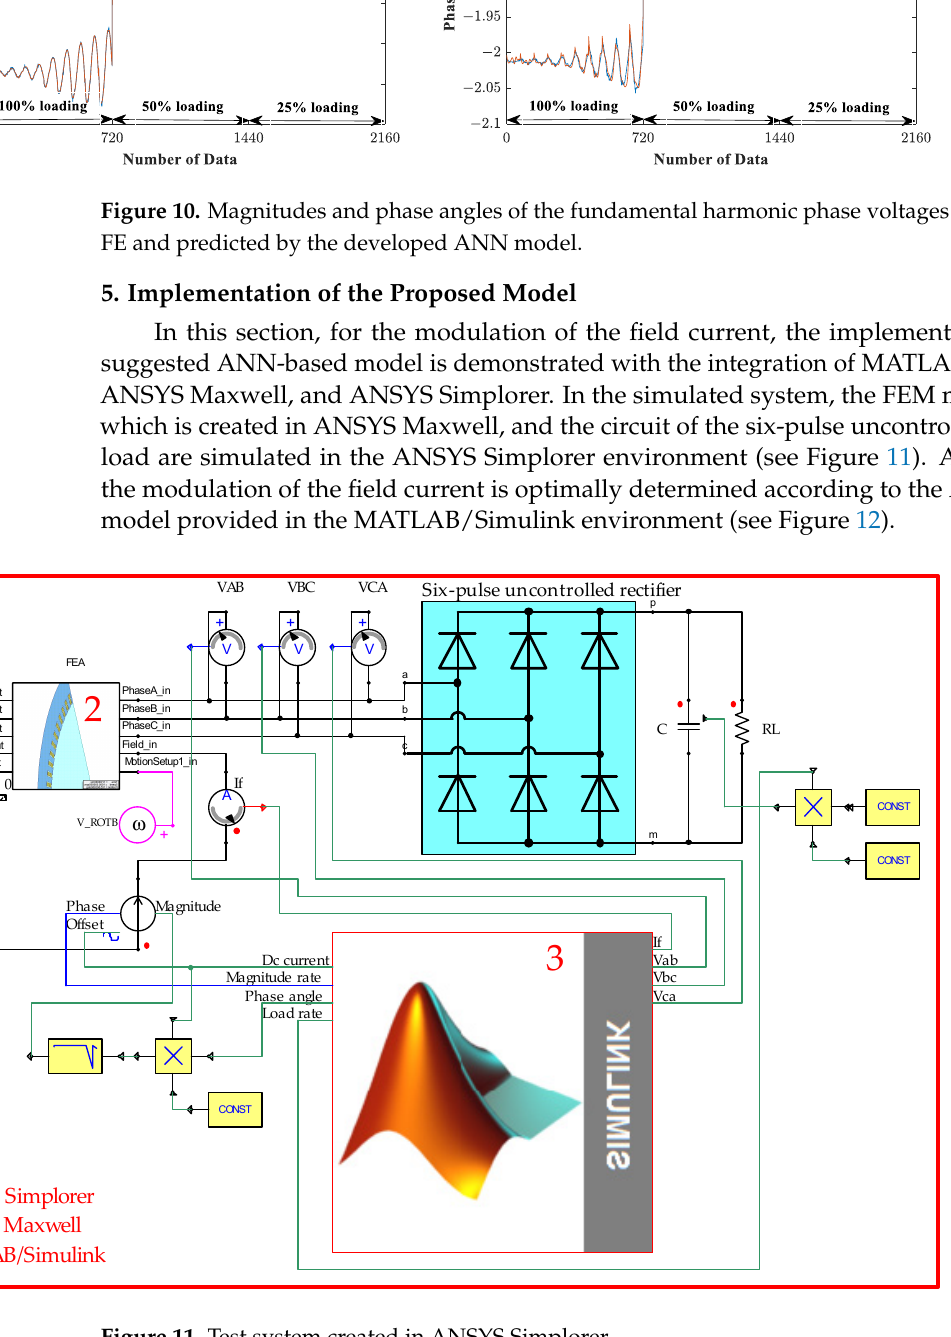
Figure 12. Implementation blocks of the proposed model in MATLAB/Simulink environment. The determination blocks of the optimal field current created in the MATLAB/Sim- ulink environment given in Figure 12 consist of two parts: •